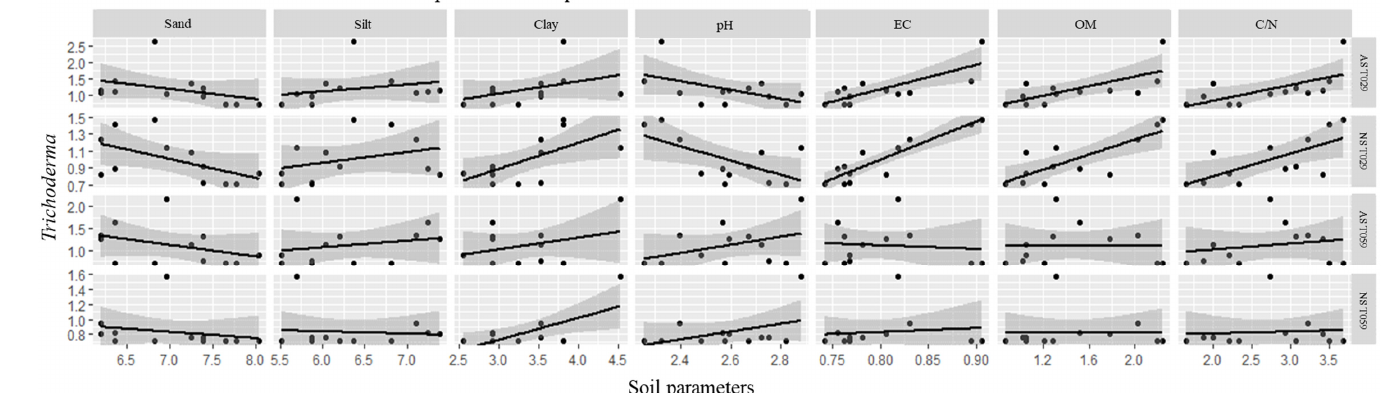
Figure 4. Correlation values of the Canonical Correlation Analysis (CCA) between Trichoderma spp. and soil parameters. Natural soil T. harzianum (NS T059), natural soil T. velutinum (NS T029), autoclaved soil T. harzianum (AS T059). autoclaved soil T. velutinum (AS T029). Electric conductivity (EC), Soil organic matter (OM), C:N ratio (C/N).